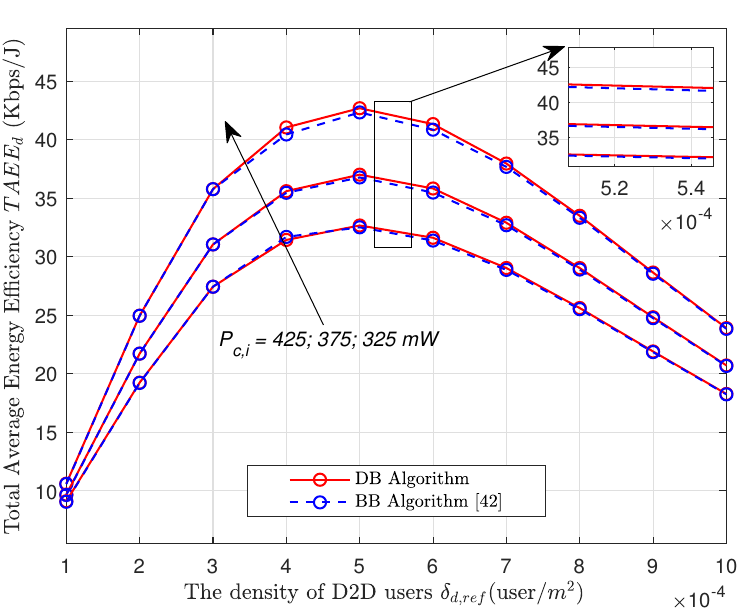
Figure 2. The TAEE of D2D communication in 2TS versus δ d , ref